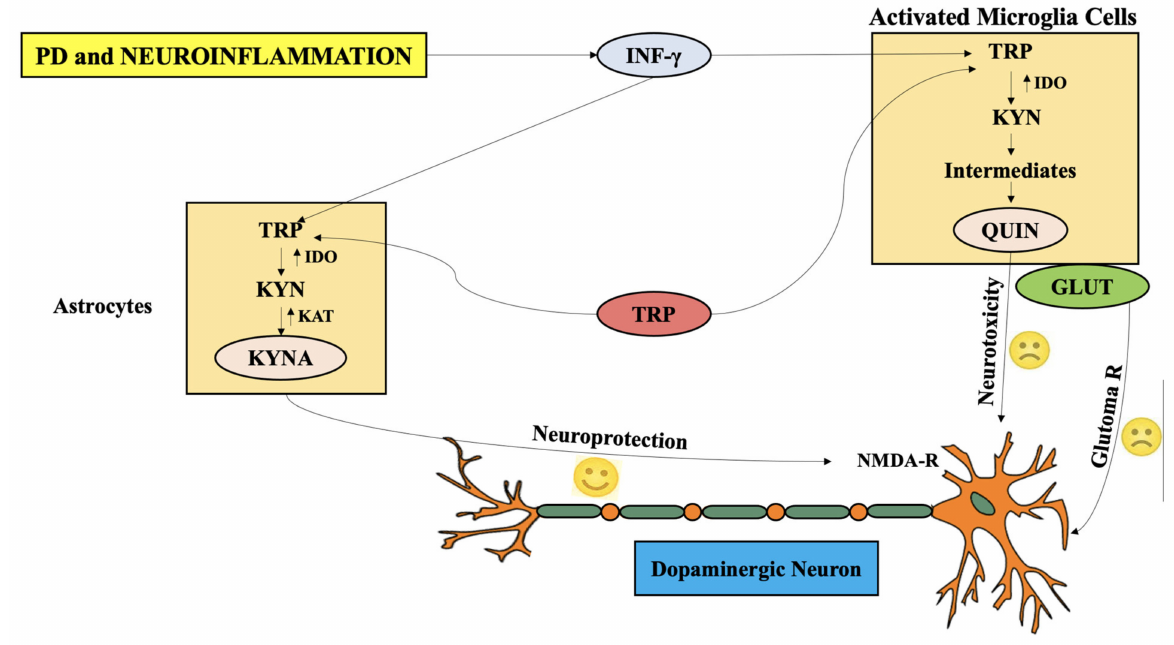
Figure 2. Neuroprotective and neurotoxic effects mediated by KYNA and QUIN in Parkinson’s disorder and neuroin- flammation. Legend: TRP—tryptophan, IDO—indoleamine 2,3-dioxygenase, KYN—kynurenine, QUIN—quinolinic acid; NMDAR—NMDA receptor; KAT—kynurenine aminotransferase, GluT—glutamate transporter, KYNA—kynurenic acid, INF- γ —interferon-gamma, ↑ increased